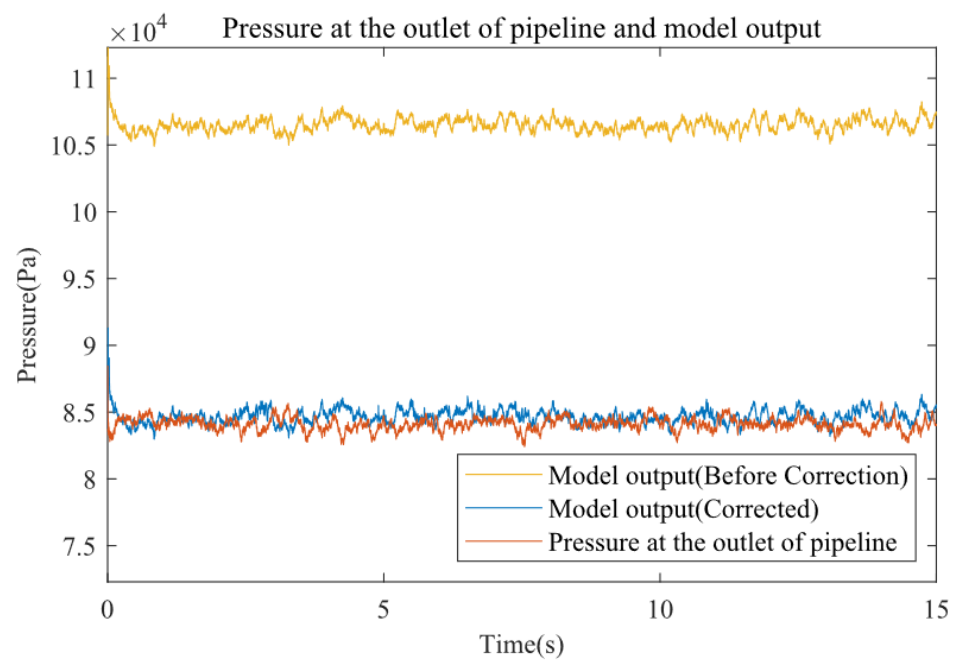
Figure 5. Comparison of pipeline measurement data and model predictions (before and after correction).